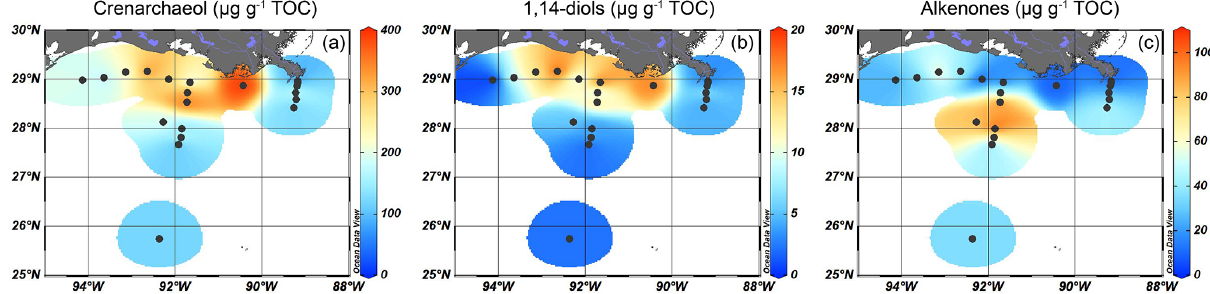
Figure 4. Marine OM production in the GoM, as indicated by isosurface plots of TOC-normalized concentrations for (a) crenarchaeol produced by Thaumarchaeota, (b) long-chain 1,14-diols produced by Proboscia diatoms, and (c) alkenones produced by haptophyte